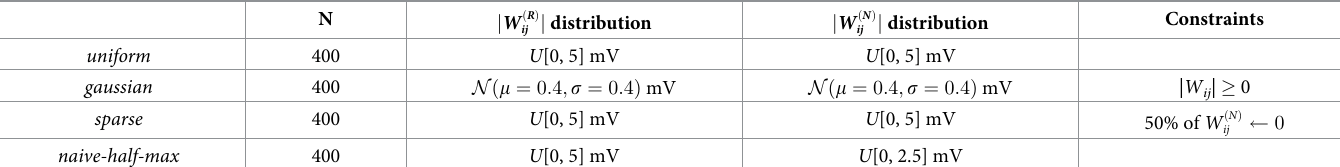
Table 2. Initial network parameters for each of the four initial weight distributions used in this